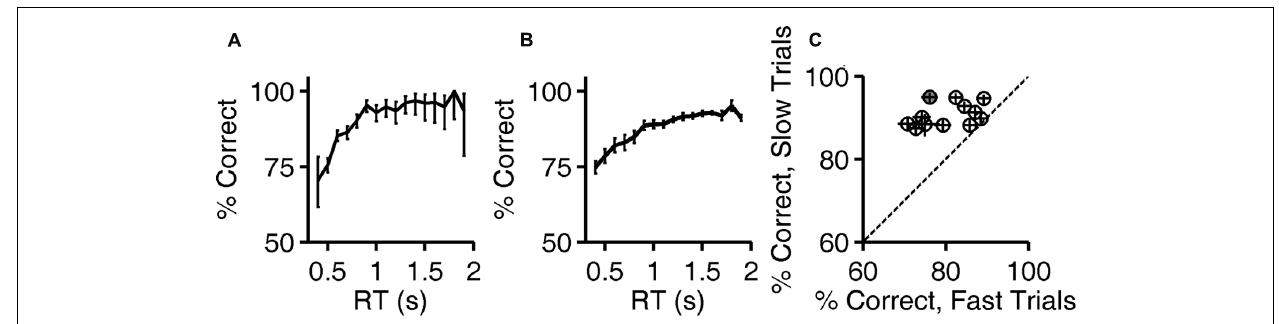
FIGURE 3 |Accuracy improves with reaction time. (A) Accuracy of exemplar discrimination as a function of reaction time for a single subject (same rat as Figures 1D and 2A,B ); error bars show the 95% binomial confidence intervals. (B) Accuracy of exemplar discrimination as a function of reaction time averaged over all N = 12 rats; error bars show SEM over the